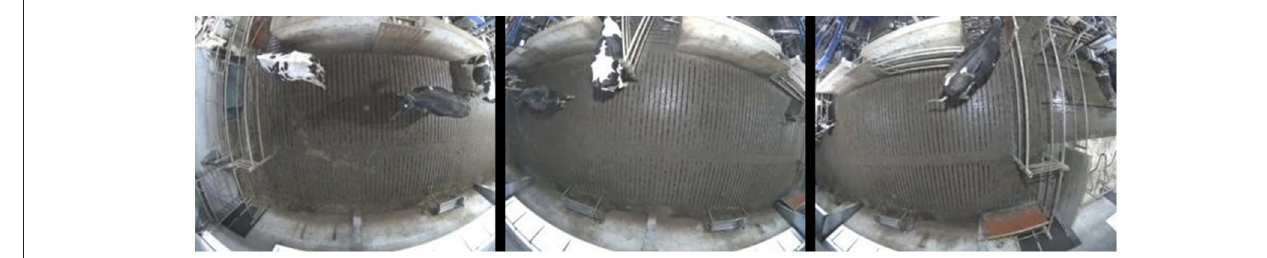
FIGURE 1 | Example frames the recorded video.